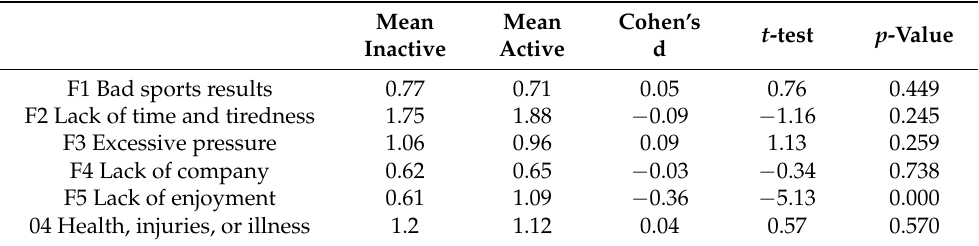
Table 8. Dropout reasons based on people who continue participating in sports and people who have stopped doing